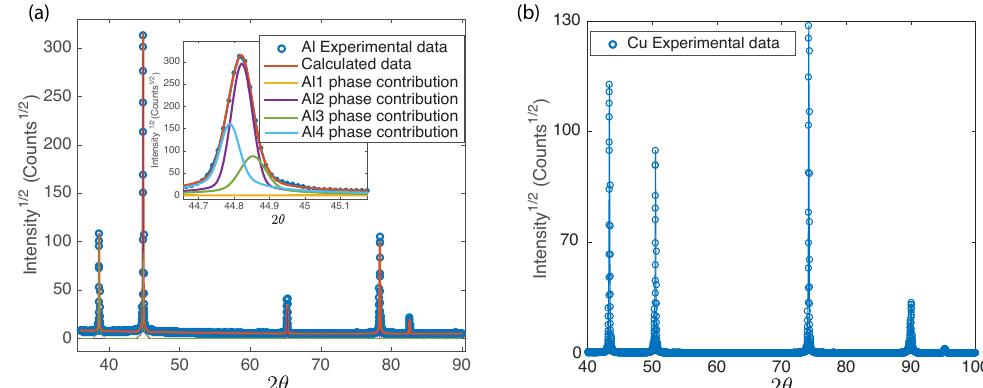
Figure 4. Example of ( a ) Aluminum and ( b ) Copper XRD pattern. ( a ) Five peaks are observed for Al, corresponding to different lattice planes: (111) (2 θ = 38.55 ◦ ), (200) (2 θ = 44.81 ◦ ), (220) (2 θ = 65.21 ◦ ), (311) (2 θ = 78.35 ◦ ) and (400) (2 θ = 99.22 ◦ ). Inset: A distribution of crystallite sizes (Al i , i = 1,2,3,4) contribute to the (200) diffraction peak (shown) as well as to the others (not shown). ( b ) For Cu samples, five peaks are observed in the angular range measured, corresponding to the following lattice planes: (111) (2 θ = 43.37 ◦ ), (200) (2 θ = 50.51 ◦ ), (220) (2 θ = 74.2 ◦ ), (311) (2 θ = 90.01 ◦ ) and (222) (2 θ = 95.23 ◦